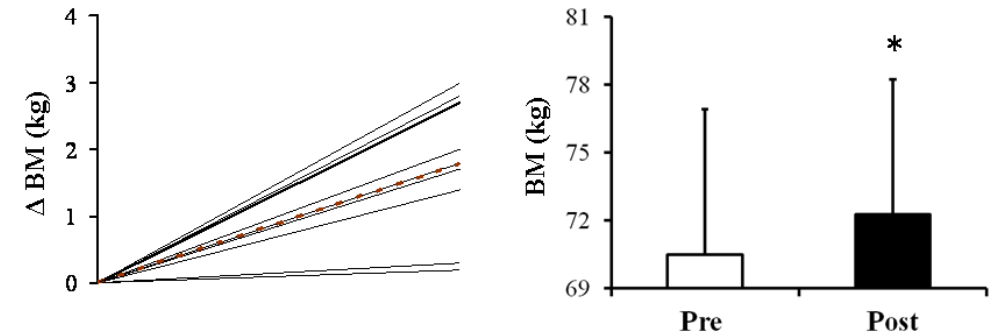
Figure 3. Changes in body mass (BM) and total body water (TBW) induced by 7-day supplementation with the hyperhydrating solution containing glycerol (Gly), creatine (Cr) and glucose (Glu). Dashed lines represent mean change of the group and solid black lines represent individual data. Bar charts show Mean ± S.D. values of BM and TBW pre- and post-supplementation, N = 9. * Significant ( P < 0.01) difference between pre- and